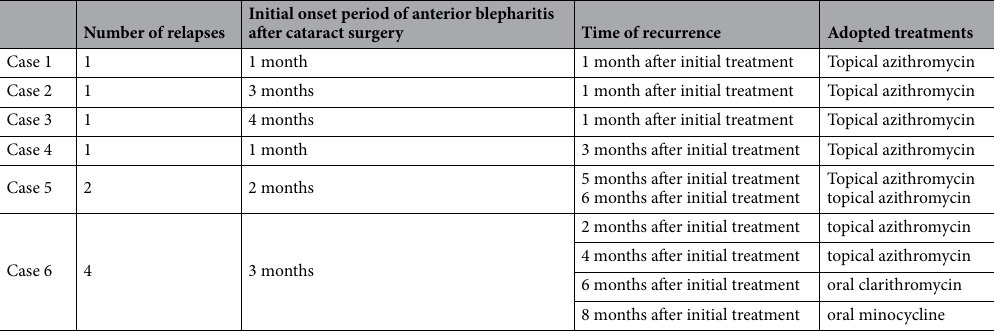
Table 2. Summary of recurrent anterior blepharitis cases in this